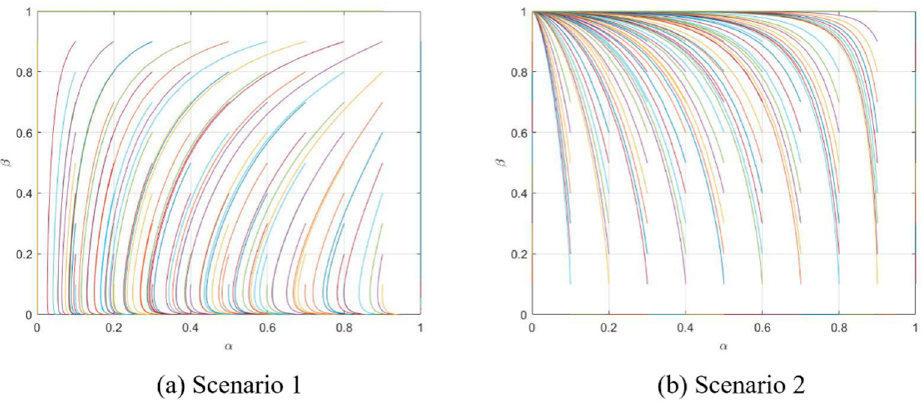
Figure 8. Simulation of scenario 1 and scenario 2 between local government and the public.